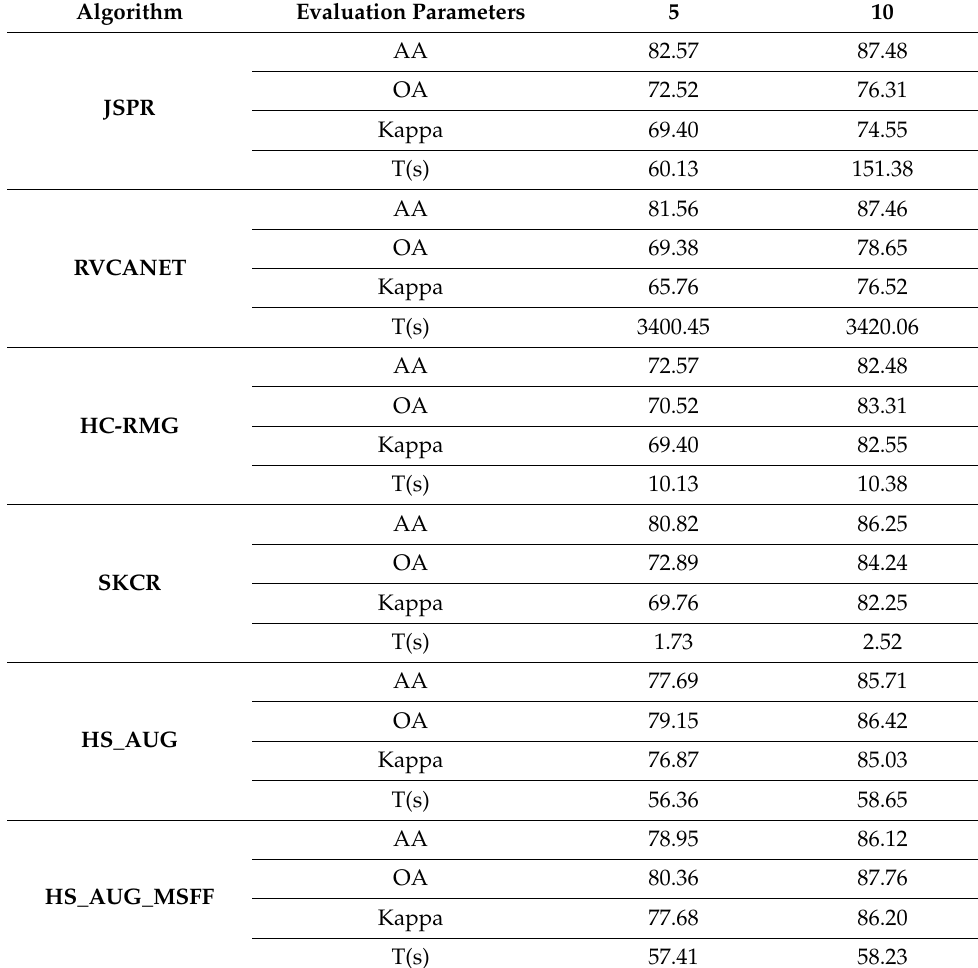
Table 3. Comparison of classification accuracies (%) of different algorithms for the Indian Pines data.